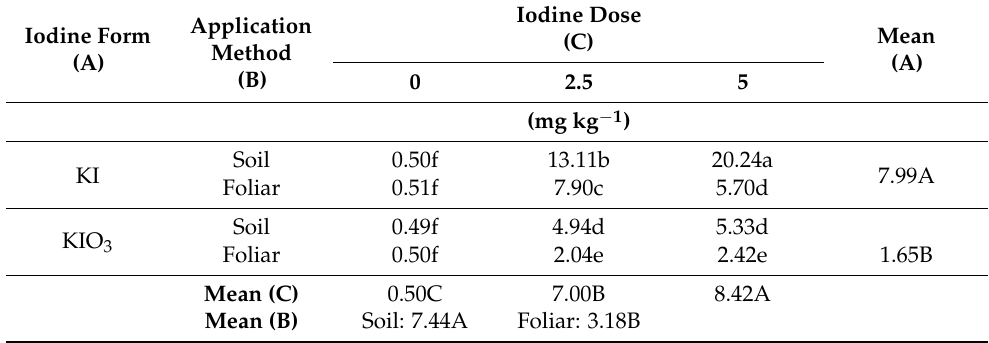
Table 1. Content of iodine in rye plants depending on I dose, form, and application